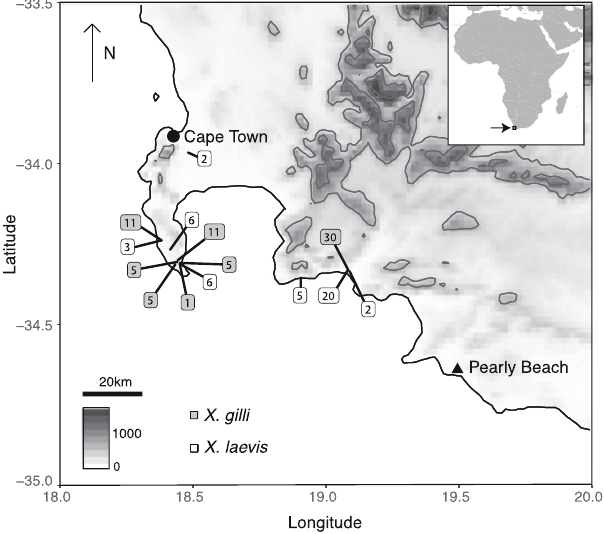
Figure 1. Sampling locations. For each species, numbers indicate the sum of number of individuals from each locality sampled in 1994 and 2013. An inset indicates the study area in southern Africa and altitude in meters is indicate on the scale. The map was made using the R package Marmap 81 using topographic data from the National Oceanic and Atmospheric Administration,